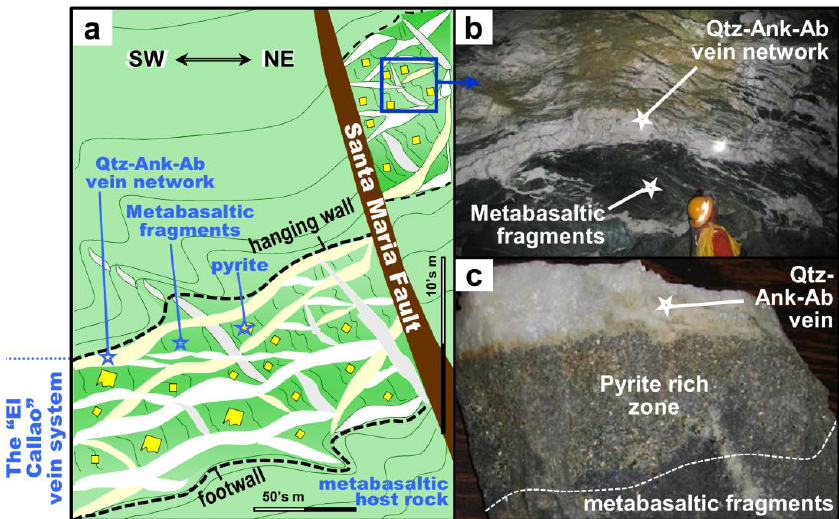
Figure 3. ( a ) Schematic illustration of the El Callao vein system, depicting the complex vein mesh and its intersection with the Santa Maria Fault (modified from Velásquez et al. [2]). ( b ) Underground photograph showing the interconnected veins, enclosing pyrite-rich metabasaltic fragments. ( c ) Photograph of a hand sample (20 cm across) showing a close-up view of a metabasaltic fragment hosting pyrite crystals, adjacent to a quartz–ankerite–albite